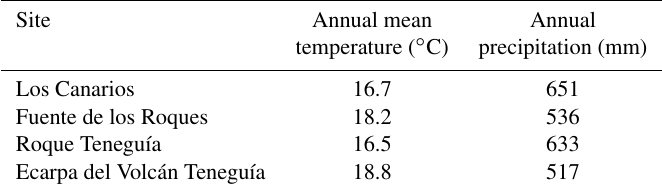
Table A2. Interpolated data from climate models for our research sites based on CHELSA Climate Data (Karger et al., 2017).